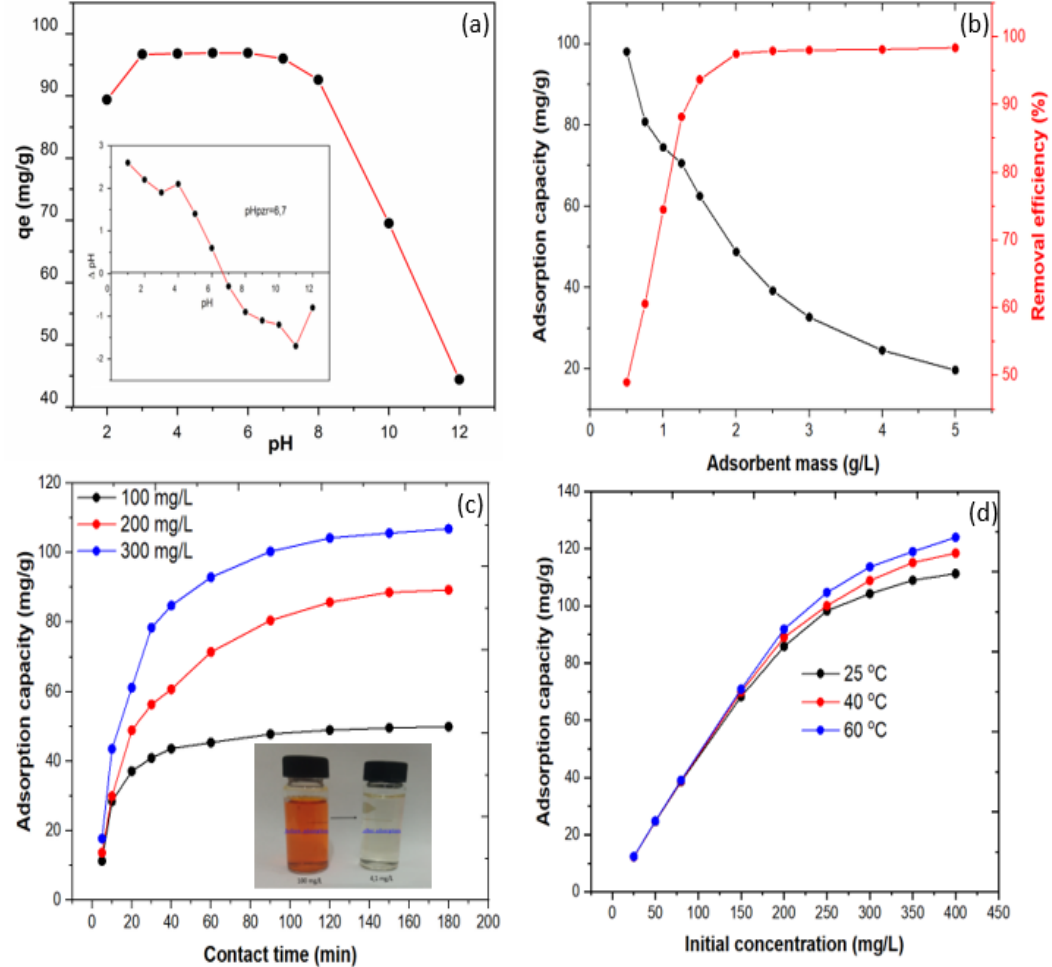
Figure 3. Effect of pH (inset: zero point charge plot) ( a ), adsorbent dose ( b ), contact time ( c ), and initial MO concentration ( d ) on MO adsorption onto CHt@MgO biocomposite.